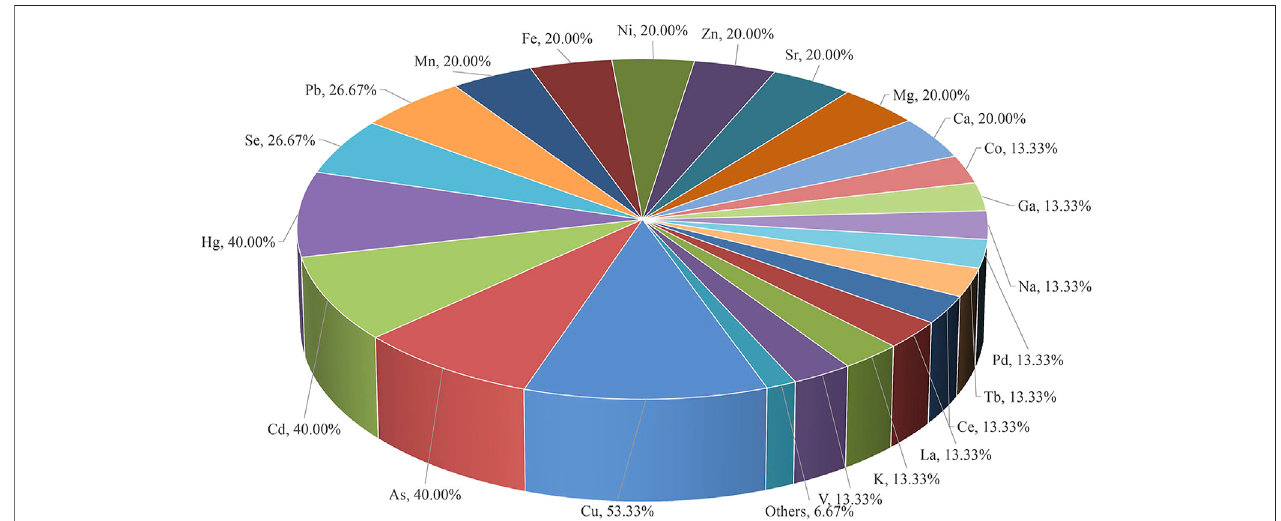
FIGURE 3 | Pie chart of elements measured by ICP-MS and their proportions in medicinal materials derived from animals.